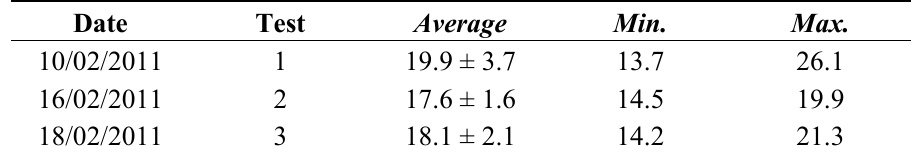
Table 4. Crop temperature during the tests measured with the compact infrared camera